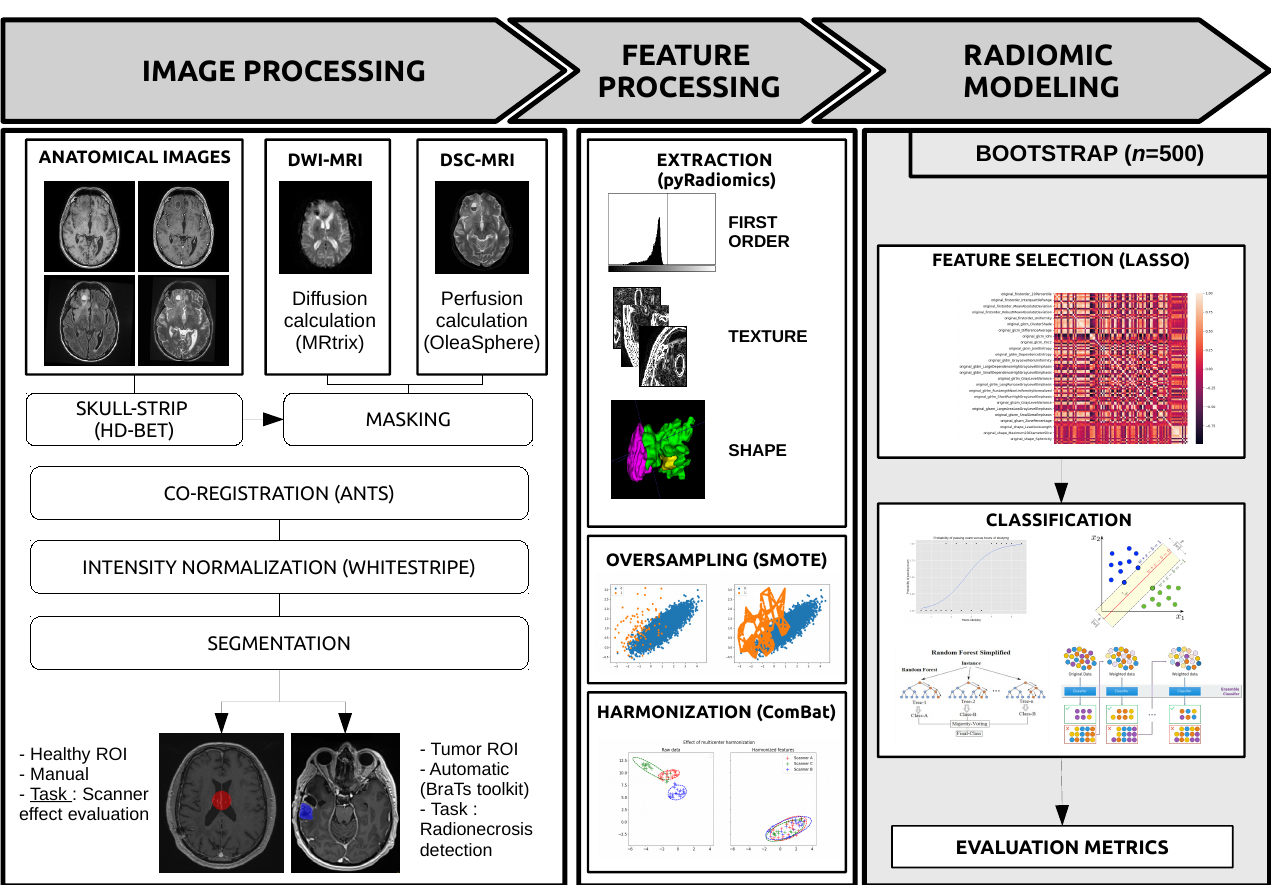
Figure 1. Radiomics